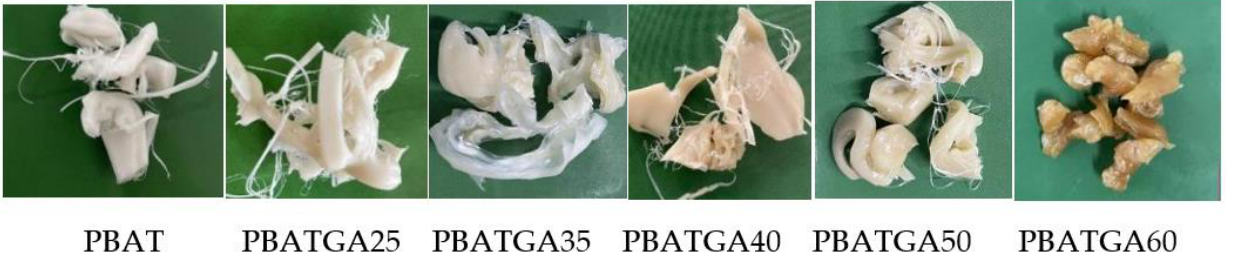
Figure 9. Appearance of PBAT and PBATGAs.